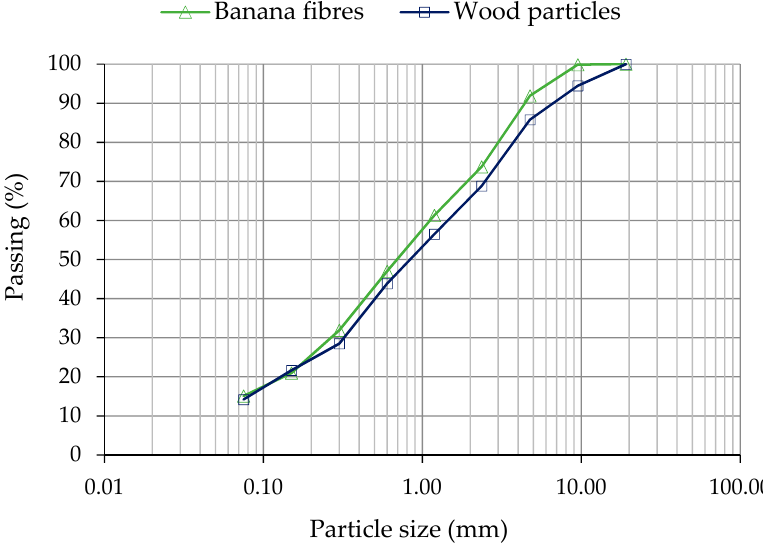
Figure 1. Particle size distribution of the banana fibres and the wood particles (adapted from [36]).